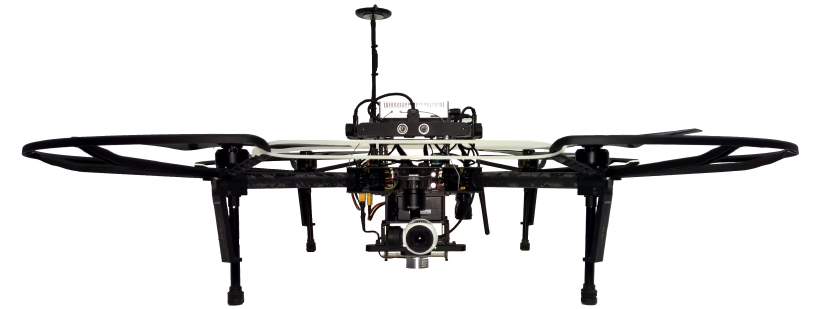
Figure 5. The robot developed for our project. The figure shows our DJI Matrice 100 quadrotor equipped with the indoor testing parts (DJI Guidance System and the propeller guards), as well as the DJI Zenmuse X3 Gimbal and Camera system, the SF30 altimeter, and the DJI Manifold onboard computer.